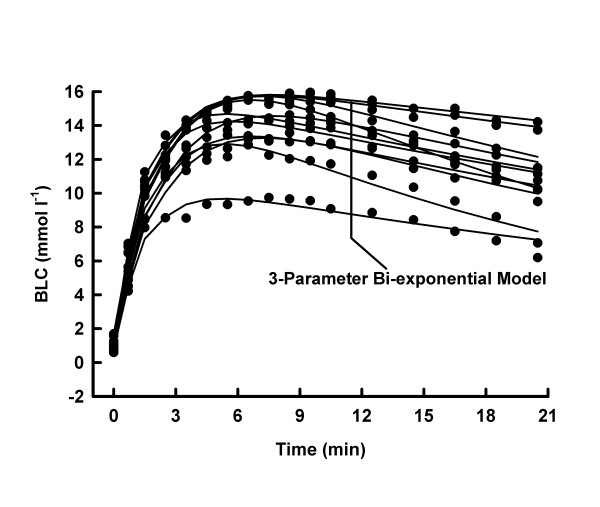
BLC, individual 3-parameter model approximations for MSE30.